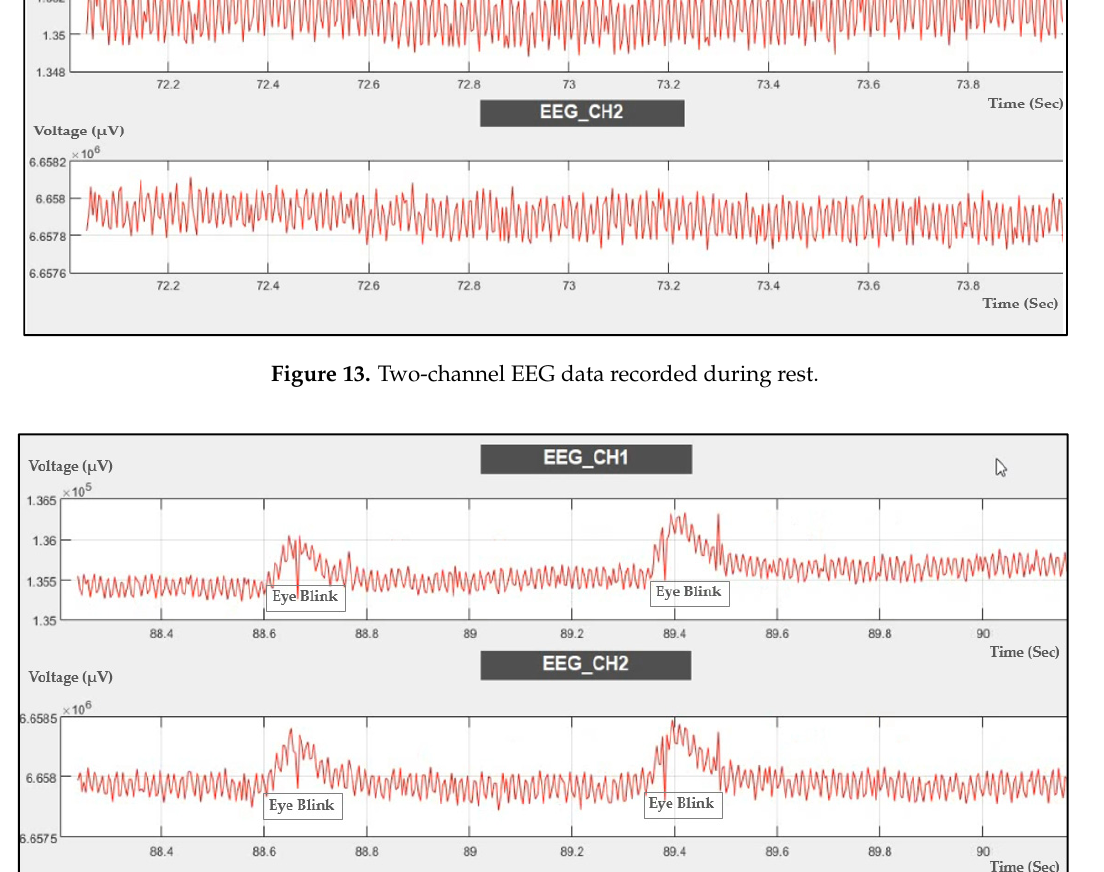
Figure 14. Two-channel EEG data recorded during eye blinking.